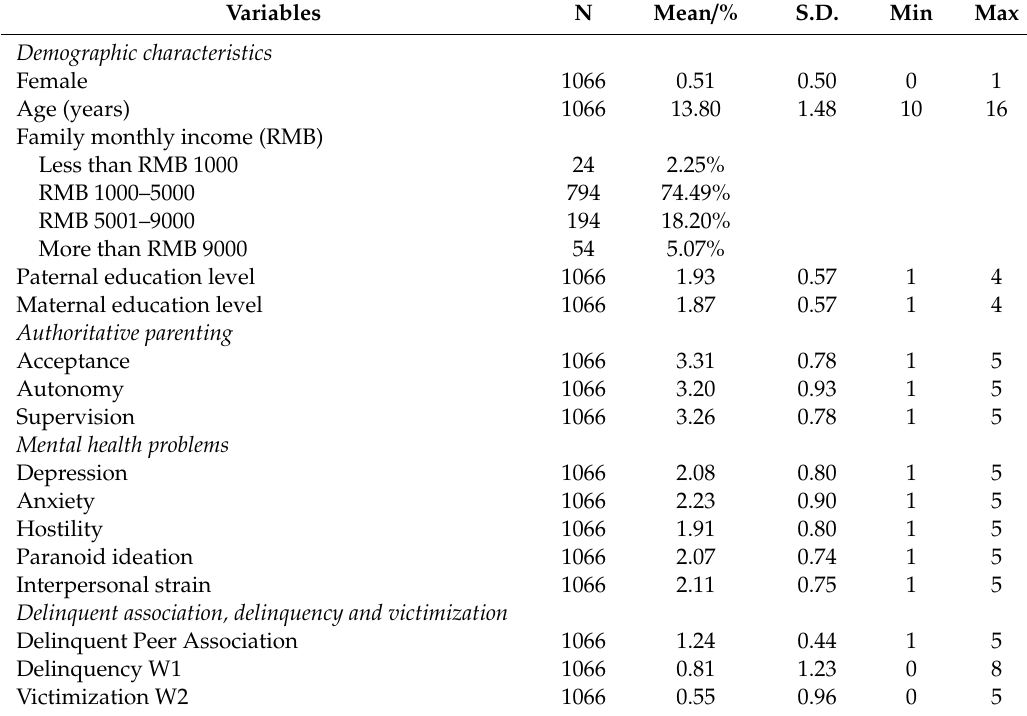
Table 1. Descriptive